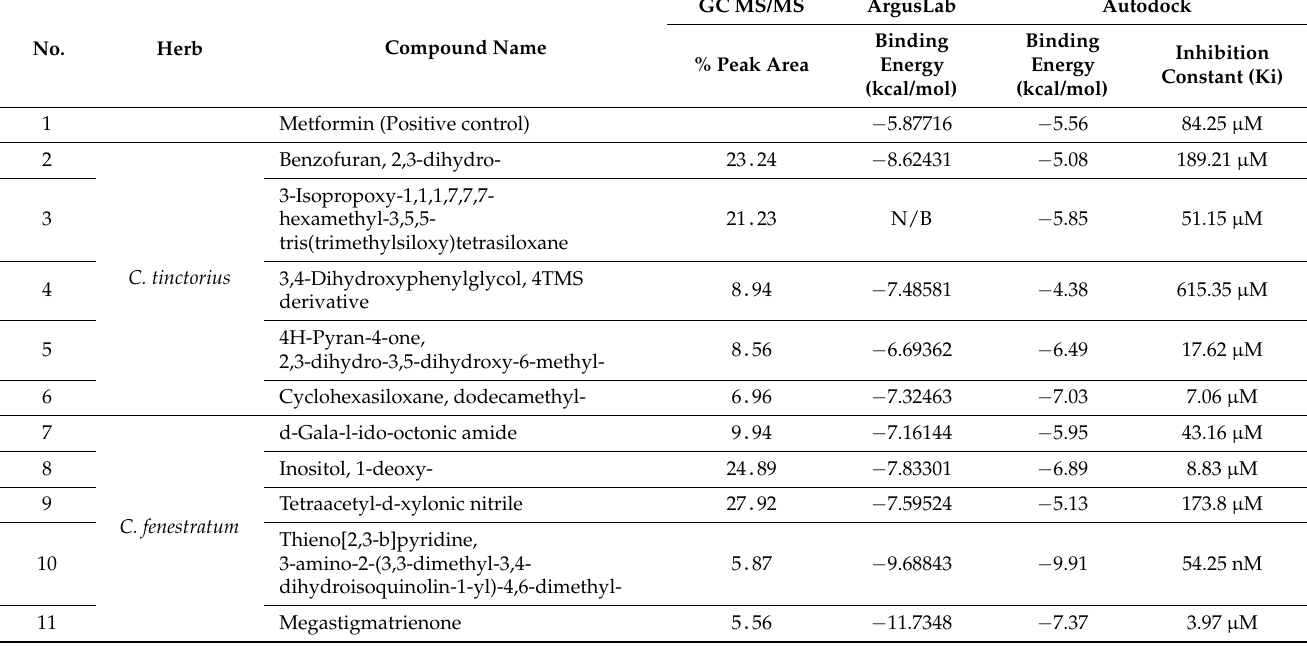
Table 15. Energy binding and phytochemical inhibition constants of herbal extracts with water at the binding sites of SREBP2 from ArgusLab and Autodock analysis and quantification of each compound through GC-MS/MS